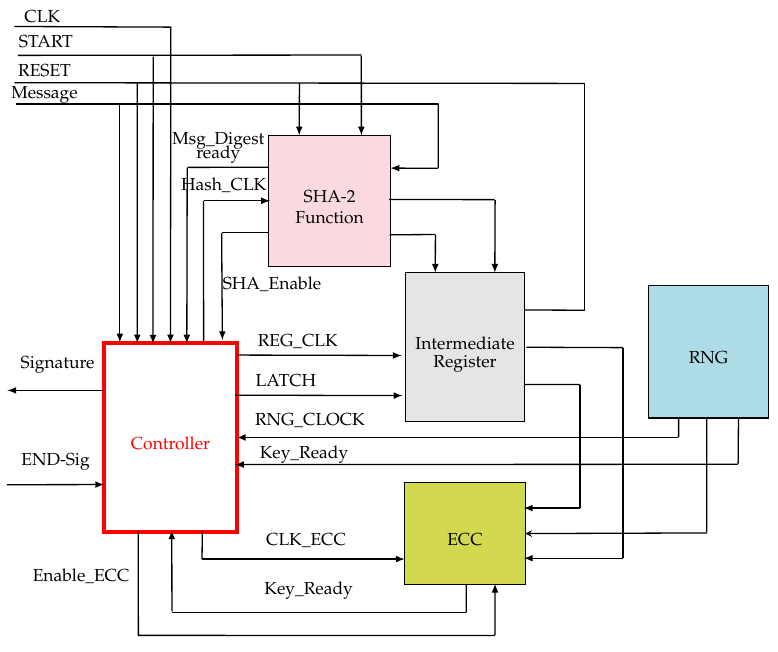
Figure 9. Proposed ECDSA Architecture.